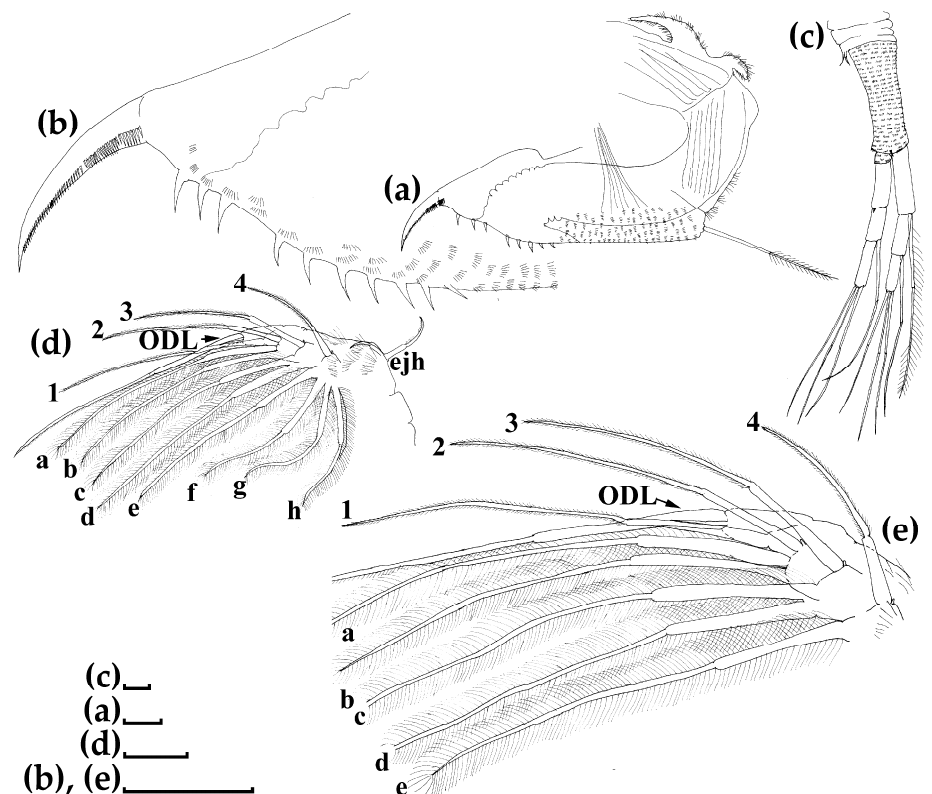
Figure 2. Daphnia arabica sp. nov., a parthenogenetic female from Al Shuwaib Dam, near Al Ain city, United Arab Emirates. ( a ) Postabdomen. ( b ) Distal portion of postabdomen. ( c ) Antenna II. ( d ) Thoracic limb I. ( e ) Distal portion of thoracic limb I. All scale bars are 0.1 mm.